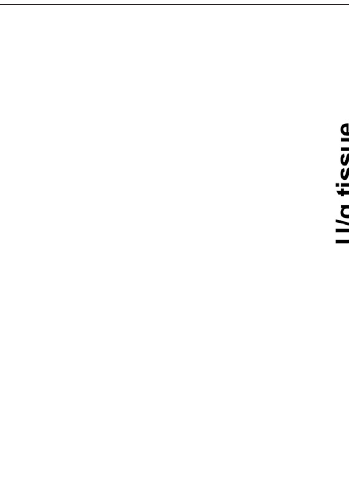
FIGURE 6 | Effect of treatment with B. pinnatum leaf extract (125, 250, and 500 mg/kg) on MPO enzyme activity in the acetic acid – induced chronic gastric ulcer model in rats. Results expressed as mean ± standard mean error ( n (cid:2) 6). ANOVA and Tukey post-test were used to calculate the statistical signi fi cance, *** p < 0.001, **** p < 0.0001 vs. ulcerated control. Healthy control, HC; ulcerated control, UC; lansoprazole (30 mg/kg),